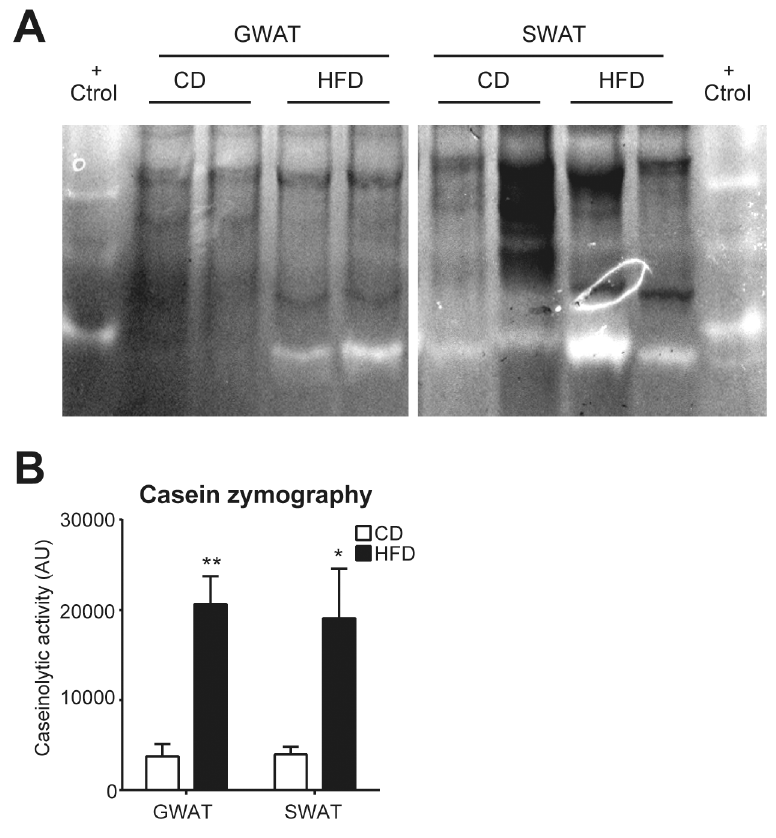
Figure 4 Caseinolytic activity in white adipose tissue from diet-induced obese mice. (A) Representative image of 2 zymography (n = 4 mice per condition) are shown. (B) Quanti- fication of caseinolytic activity by arbitrary units (AU) in GWAT and SWAT on CD and HFD. Results are expressed as mean ± SEM. * p < 0.05; ** p <